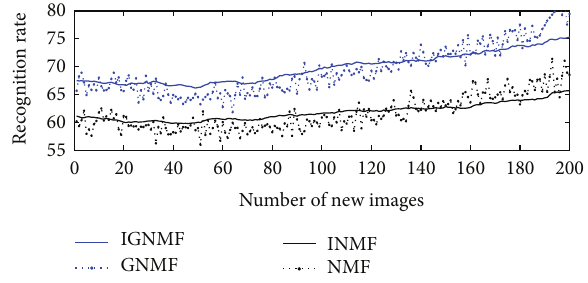
Figure 3: The average recognition rate during incremental study for the FERET database.